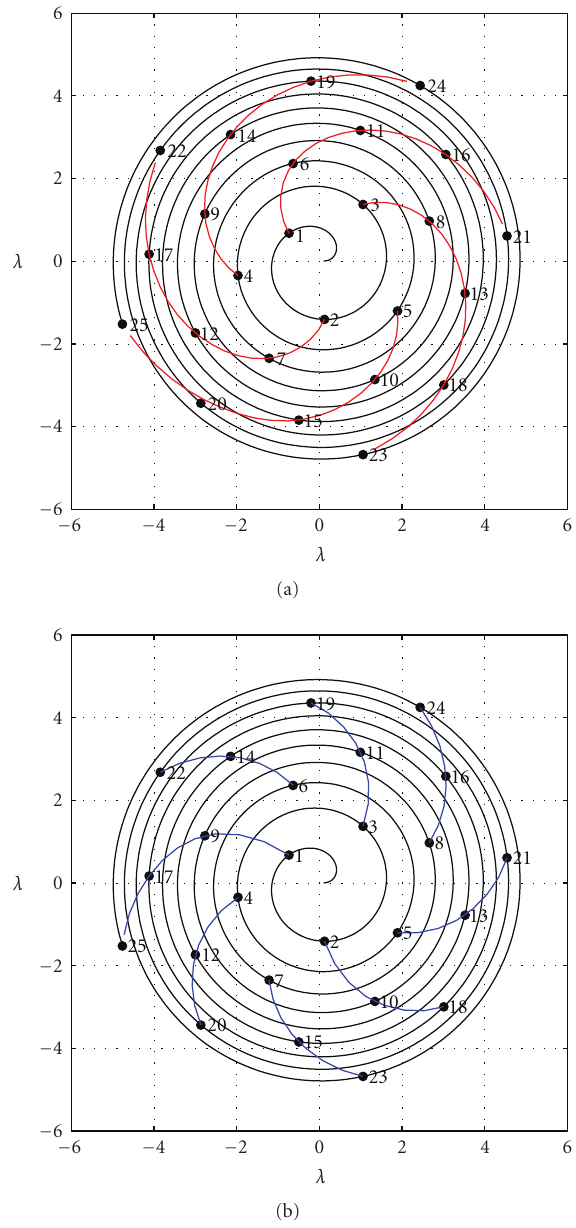
Figure 13: Sunflower array configuration: the elements are num- bered starting from the center. In this case, 5 clockwise Fibonacci spirals appear, red line, and 8 anticlockwise, in blue line. The interval of identificative numbers between elements on the same Fibonacci spiral is always equal to the number of spirals occurring, in this figure notice 22 − 14 = 14 − 6 = 8 and 24 − 19 = 19 − 14 =